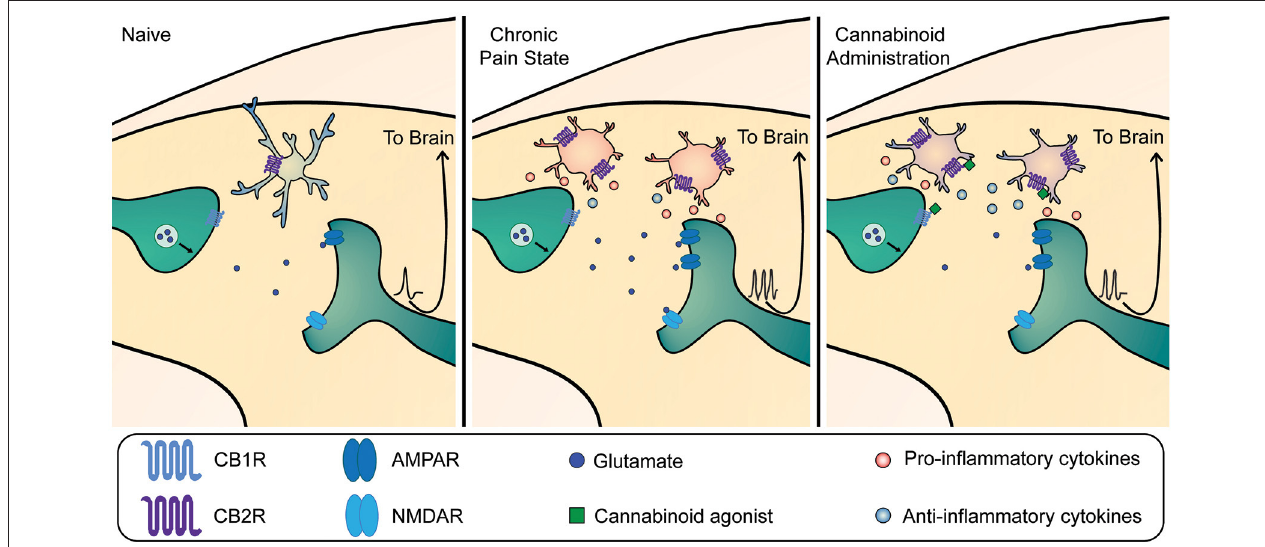
FIGURE 2 | Mechanism of cannabinoid-mediated reduction in dorsal horn hyperexcitability in chronic pain. Left panel: Under homeostatic conditions, microglia are present in their surveillant phenotype. Cannabinoid receptor 1 (CB1R) is expressed on primary afferent terminals. Mid panel: In chronic pain states, microglia become active and contribute to dorsal horn neuron hyperexcitability through release of pro-inflammatory mediators that act on nociceptive circuitry to increase output sent to the brain. This occurs in tandem with other neuronal mechanisms including an increase in α -amino-3-hydroxy-5-methyl-4-isoxazolepropionic acid receptor (AMPAR) trafficking and phosphorylation, and phosphorylation of N-methyl-D-aspartate receptors (NMDAR), which all contribute to central sensitization. Right panel: Exogenous and endogenous cannabinoids can bind to CBRs on both neurons and microglia within the dorsal horn. CB1Rs are present predominantly on neurons at the presynaptic terminal, where their activation decreases vesicular release to reduce glutamate release onto nociceptive projection neurons. CB2Rs are present predominantly on microglia, where their activation shifts microglia to produce more anti-inflammatory mediators and fewer pro-inflammatory mediators. Together, activation of both neuronal and microglial CBRs leads to a reduction in nociceptive output.